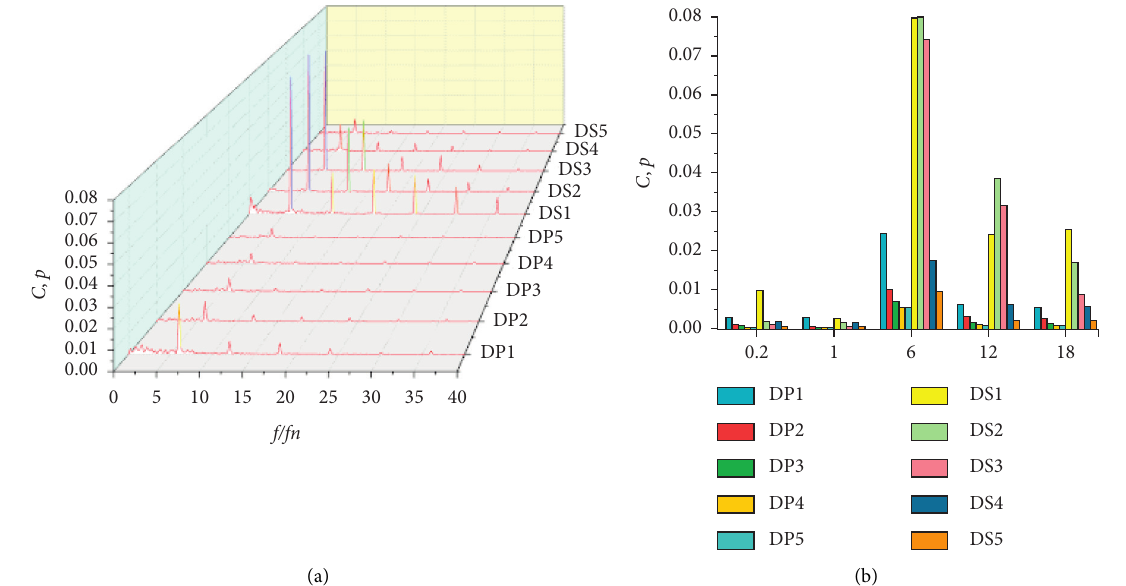
Figure 12: Pressure pulsation near guide vane blades. (a) Frequency domain. (b)